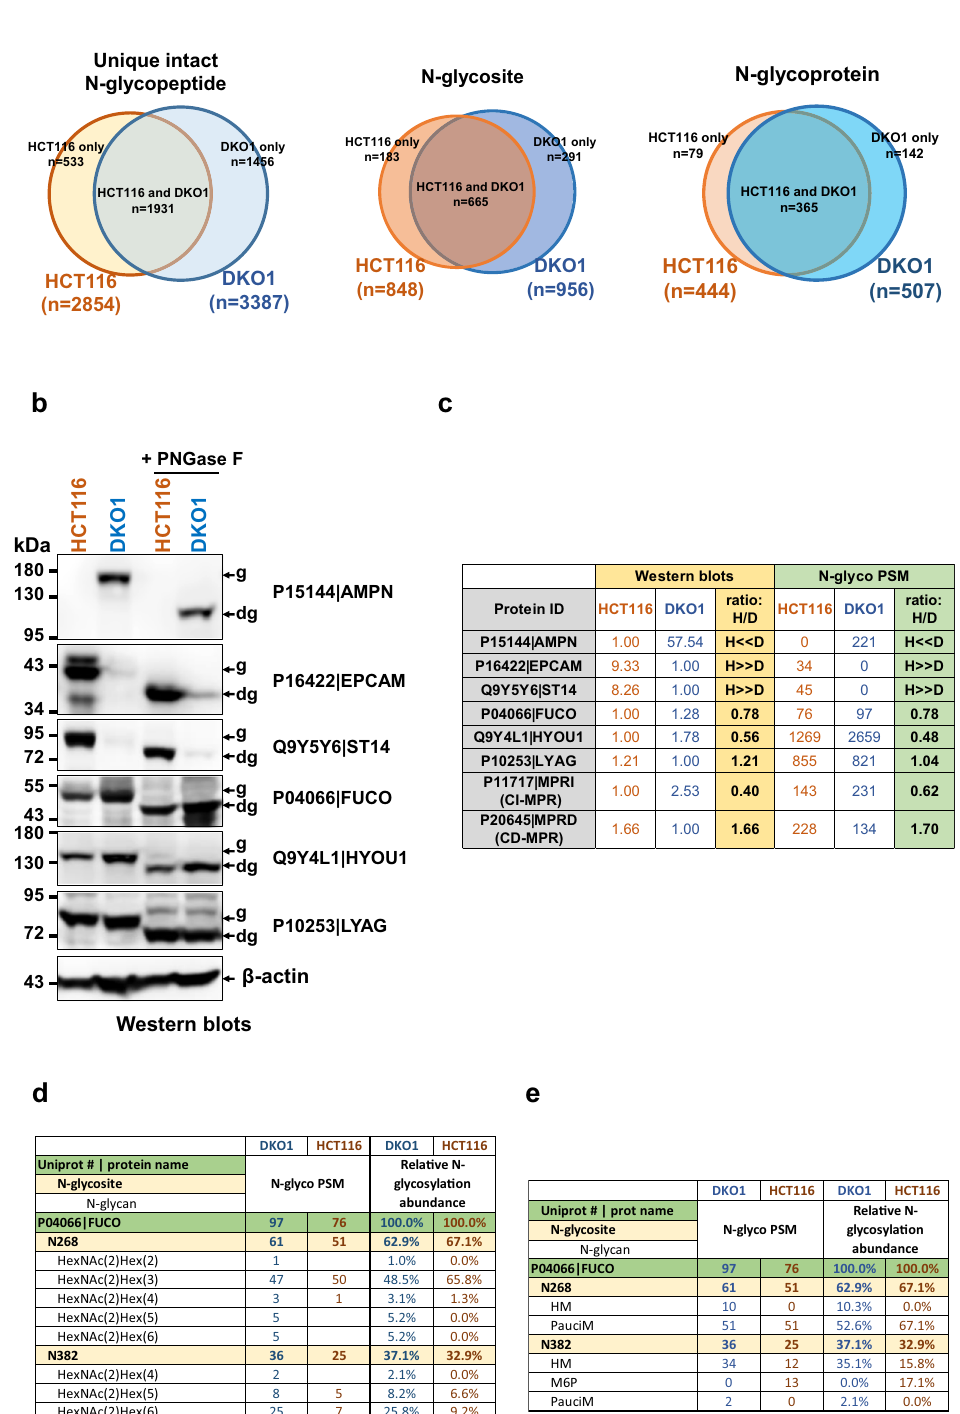
protein identity (Uniprot # and protein name) is listed on the top and N-glycosites (amino acid position of the N-glycan attaching asparagine (N)) are listed below the protein identity. N-glycan composition pertaining to each glycosite is listed below the glycosite. Next to the protein identity, glycosite, and N-glycan composition, the corresponding N-glyco PSM identi fi ed from HCT116 and DKO1 cells are